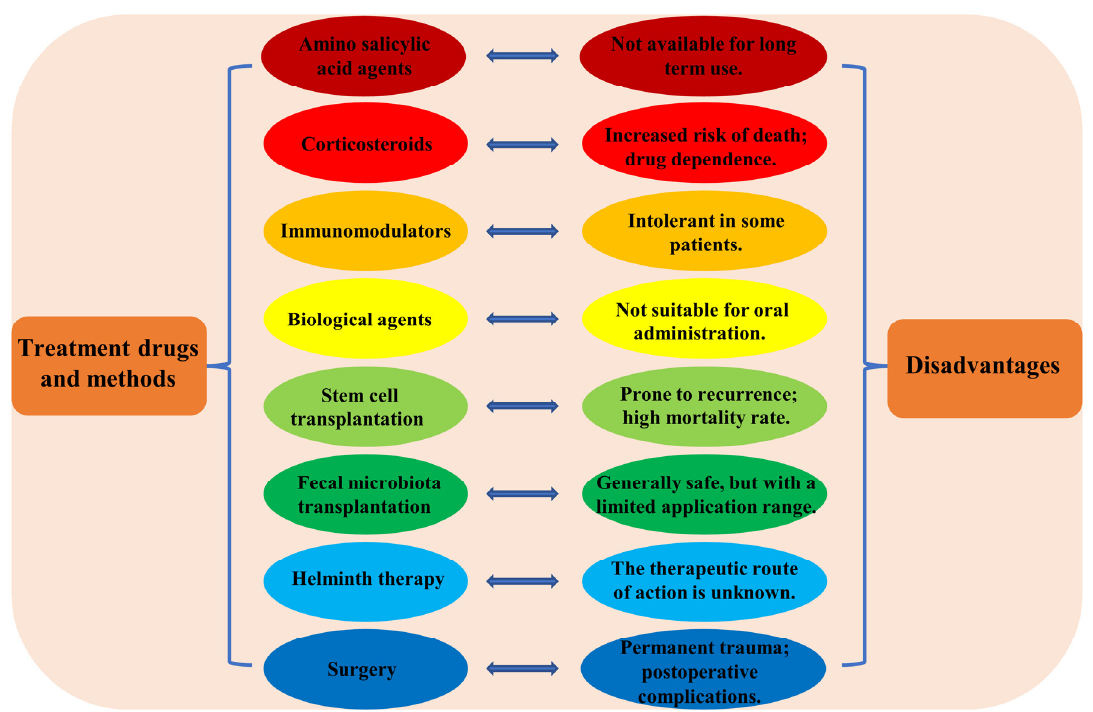
Figure 2. Therapeutic drugs and methods for IBD and their disadvantages.